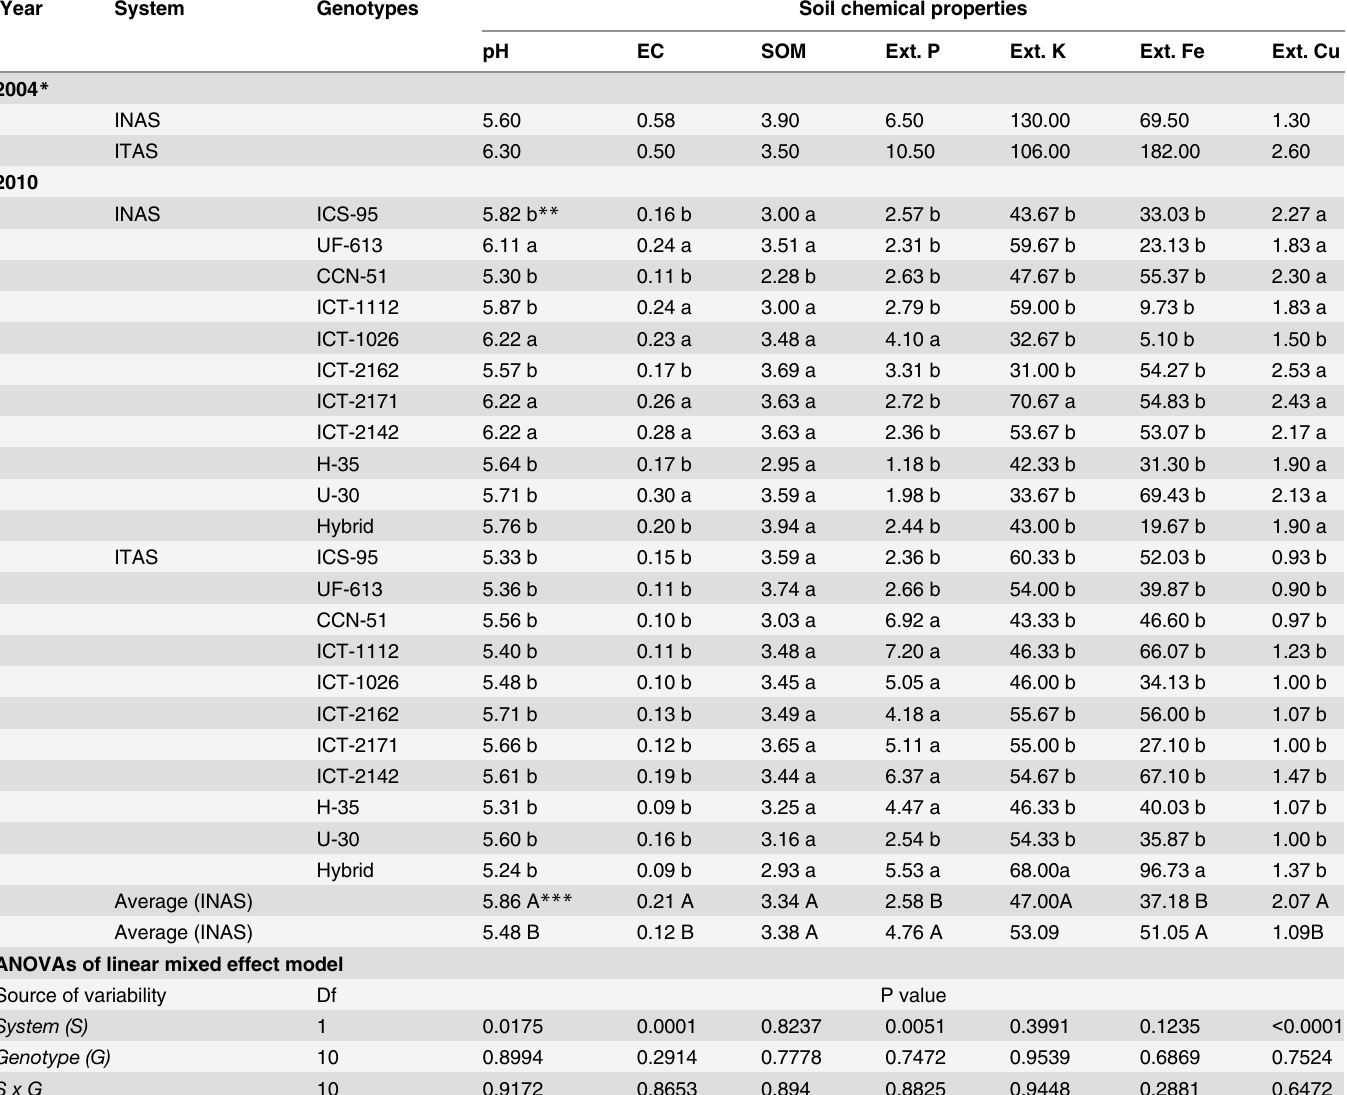
Table 8. Soil Chemical Properties: pH, EC, SOM, Ext. P, Ext. K, Ext. Fe and Ext. Cu, for 2010 Influenced by Systems of Cacao Management and Cacao Genotypes at 0-20cm Depth. Year System